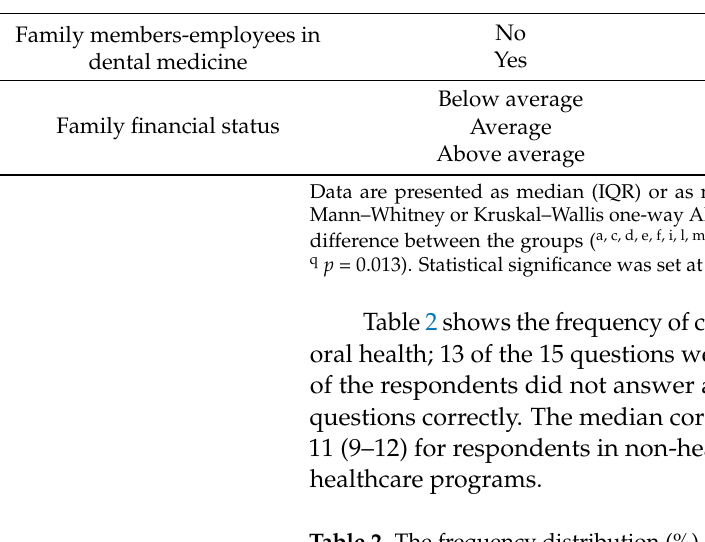
Table 2. The frequency distribution (%) of students’ answers about oral